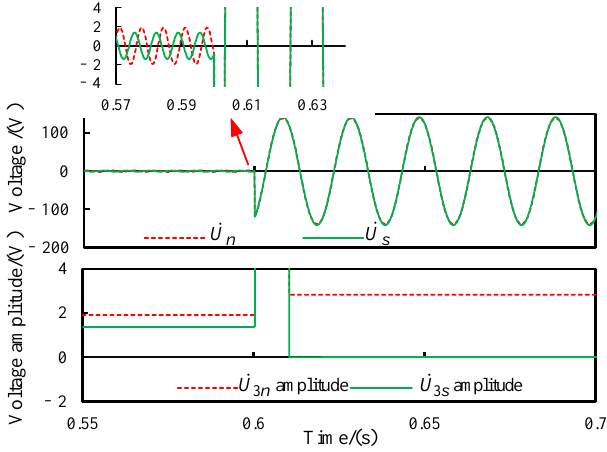
Figure 14. The third harmonic voltage of when a metal ground fault occurs at the generator’s terminal.